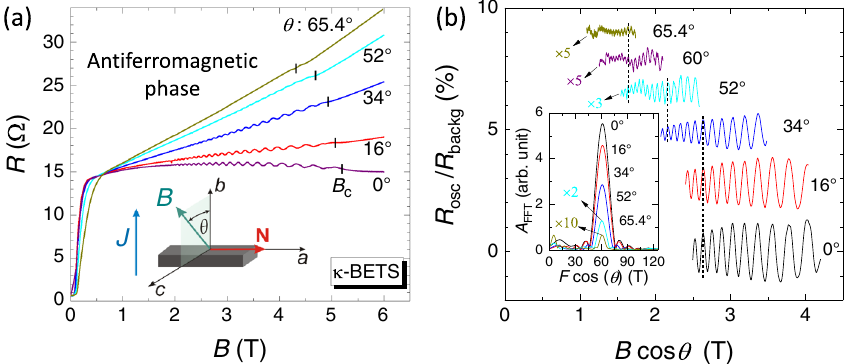
Fig. 2 SdH oscillations in the antiferromagnetic phase of κ -BETS. a Examples of the fi eld-dependent interlayer resistance at different fi eld orientations, at T = 0.42 K. The AF – PM transition fi eld B c is marked by vertical dashes. Inset: the orientation of the current J and magnetic fi eld B relative to the crystal axes and the Néel axis N . b Oscillating component, normalized to the non-oscillating B -dependent resistance background, plotted as a function of the out-of-plane fi eld component B ? ¼ B cos θ . The curves corresponding to different tilt angles θ are vertically shifted for clarity. For θ ≥ 52° the ratio R osc / R backg is multiplied by a constant factor, as indicated. The vertical dashed lines are drawn to emphasize the constant oscillation phase in these coordinates. Inset: FFT spectra of the SdH oscillations taken in the fi eld window [3 – 4.2] T. The FFT amplitudes at θ = 52° and 65. 4° are multiplied by a factor of 2 and 10, respectively.